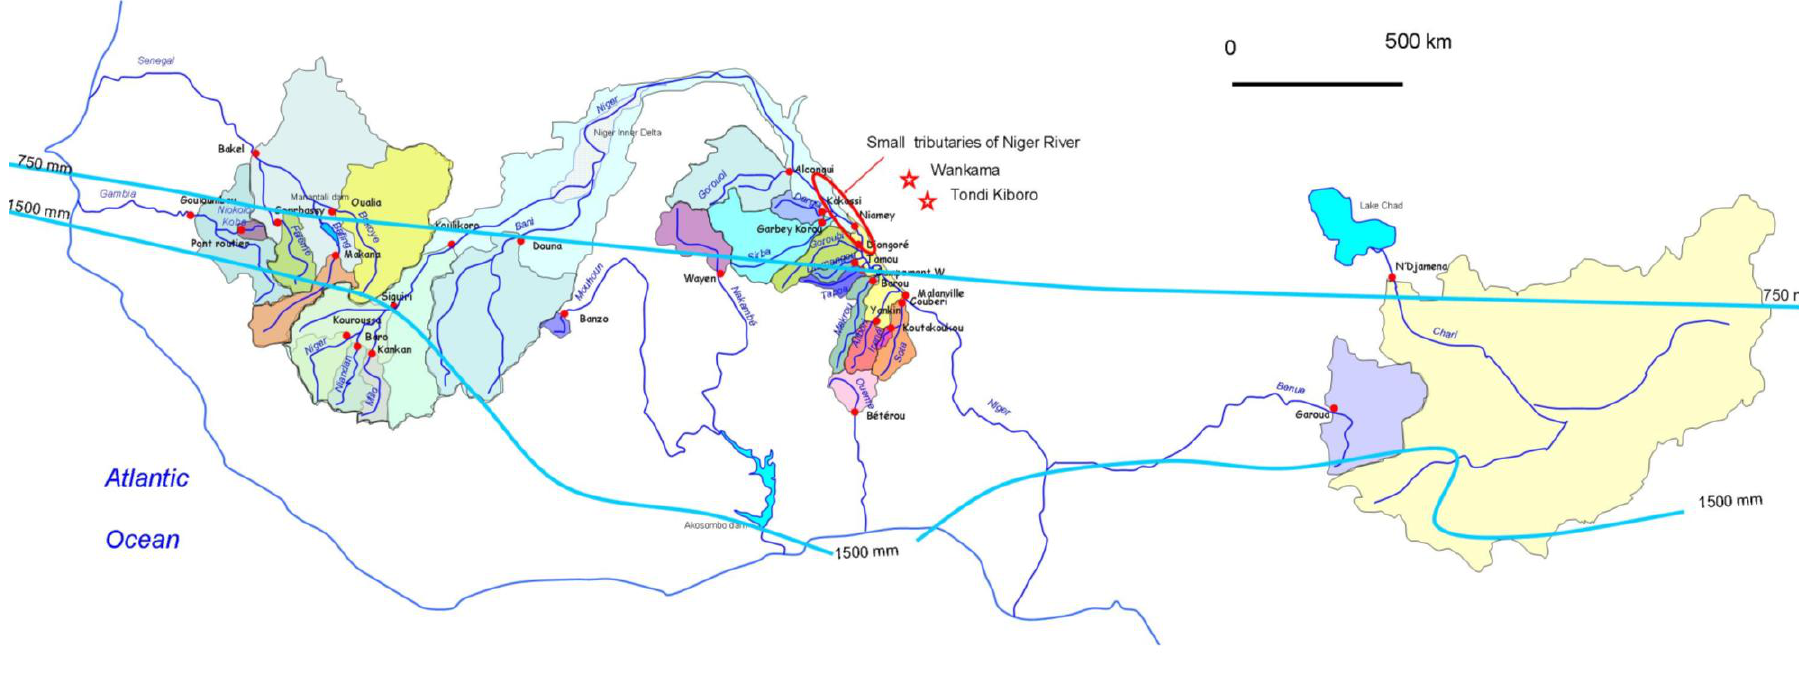
Figure 1. Location of the experimental sites and rivers analyzed and/or cited. The 700 and 1,400 mm isohyets are the common southern boundaries of Sahel and